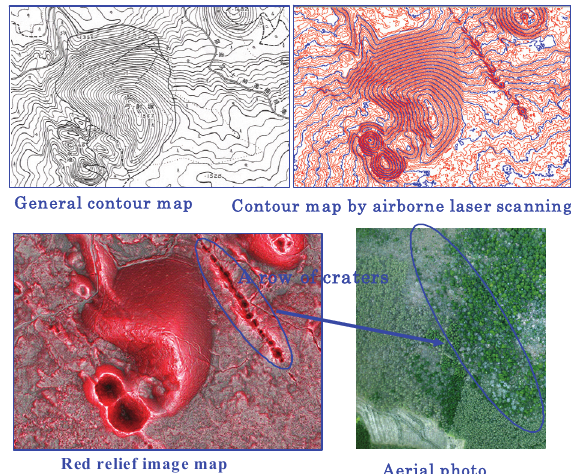
Fig 3. Laser scanner system (Harrier56 by TopoSys)